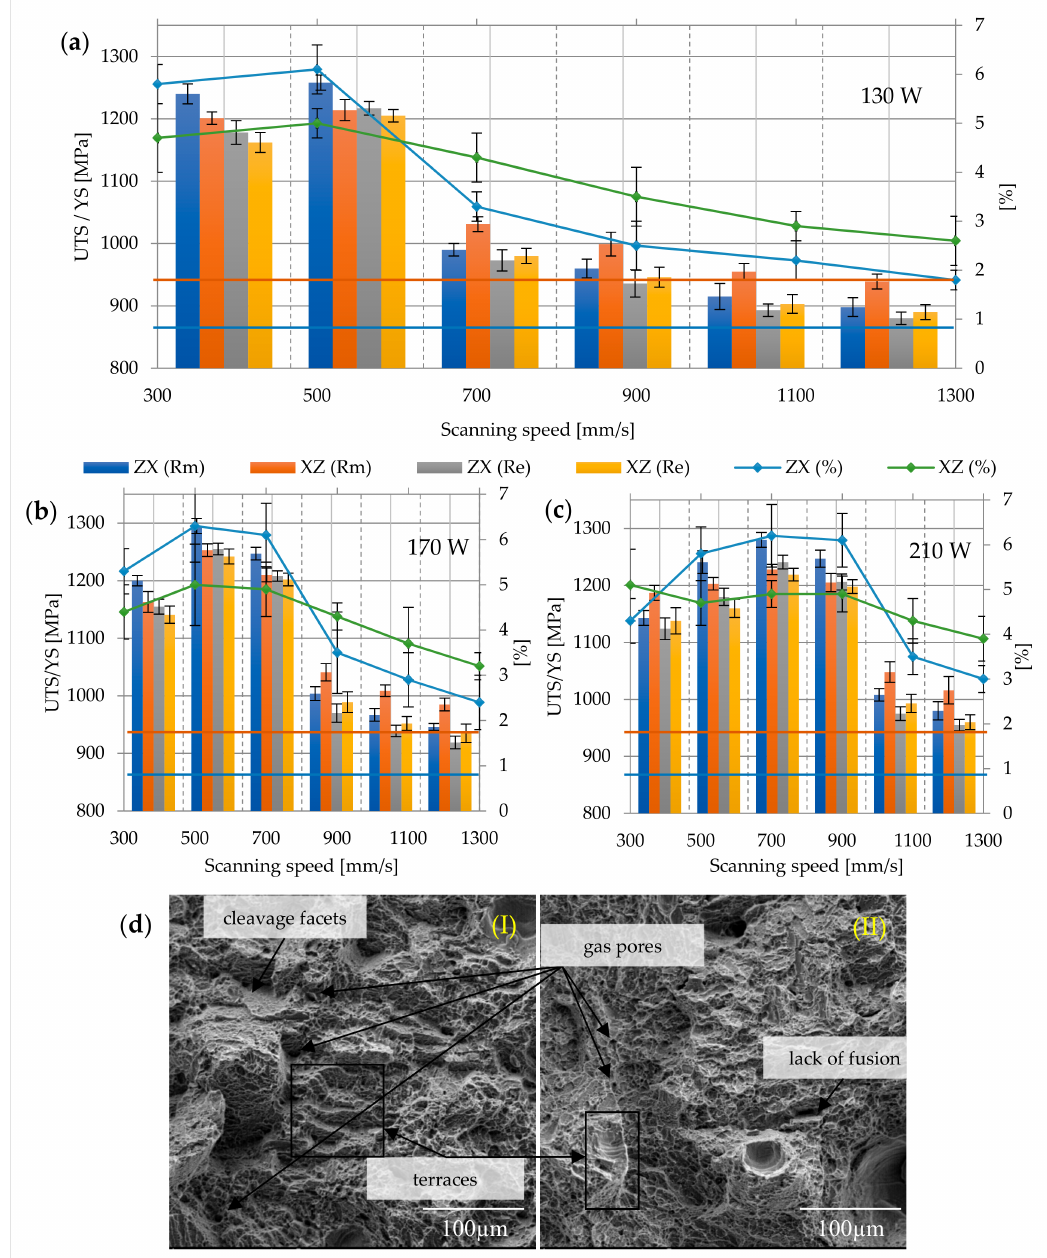
Figure 6. Strength parameters of as–built samples with di ff erent laser speeds and powers: ( a ) 130 W, ( b ) 170 W, ( c ) 210 W, and ( d ) fracture surface: (I) 130 W, 300 mm / s, ZX; (II) 130 W, 300 mm / s, XZ; 900 × ; Rm min and Re min for Ti6Al4V in accordance with ASTM F